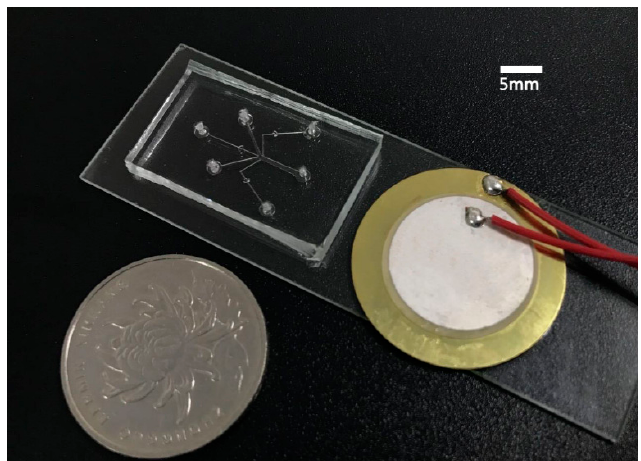
Figure 3. Photograph of the acoustofluidic gradient generator.